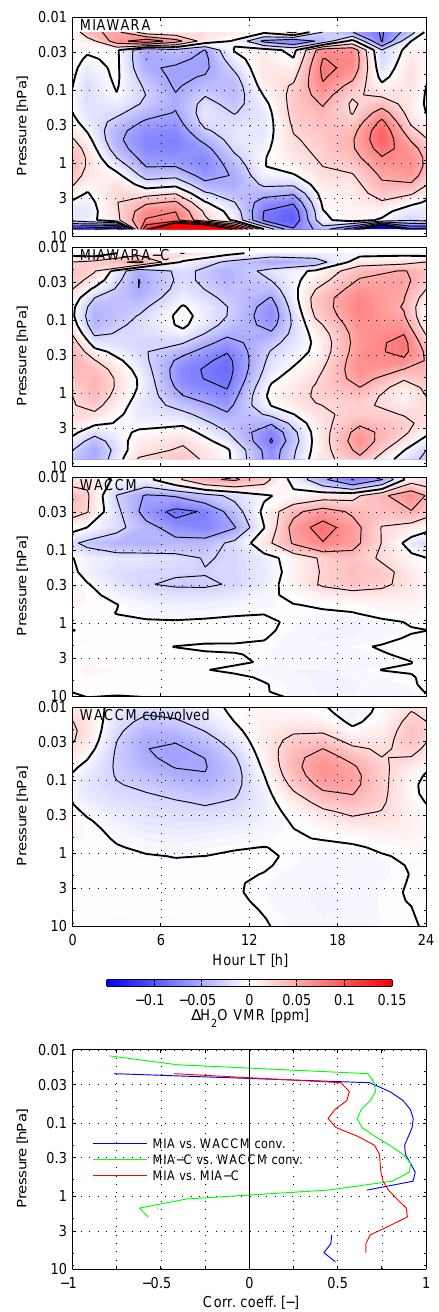
Fig. 1. Diurnal variations of water vapor [ppm] from observa- tional (MIAWARA and MIAWARA-C) and model (WACCM and WACCM convolved) data averaged over the months of December to April. The contour line interval is 0.025ppm. The lowermost panel shows the linear correlation coefficients between the obser- vational and the convolved WACCM data. Correlations are only shown where they exceed 95% confidence ( p< 0 . 05). Times are given in local